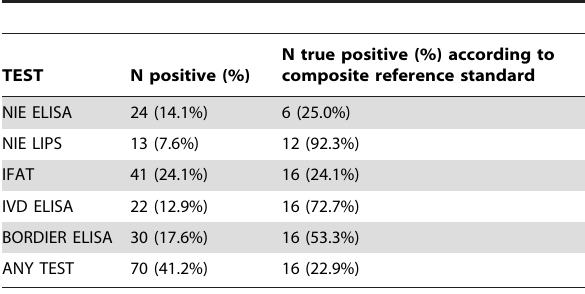
Table 3. Test results on samples from subjects with no Ss larvae in stool and risk of exposure (170 samples).